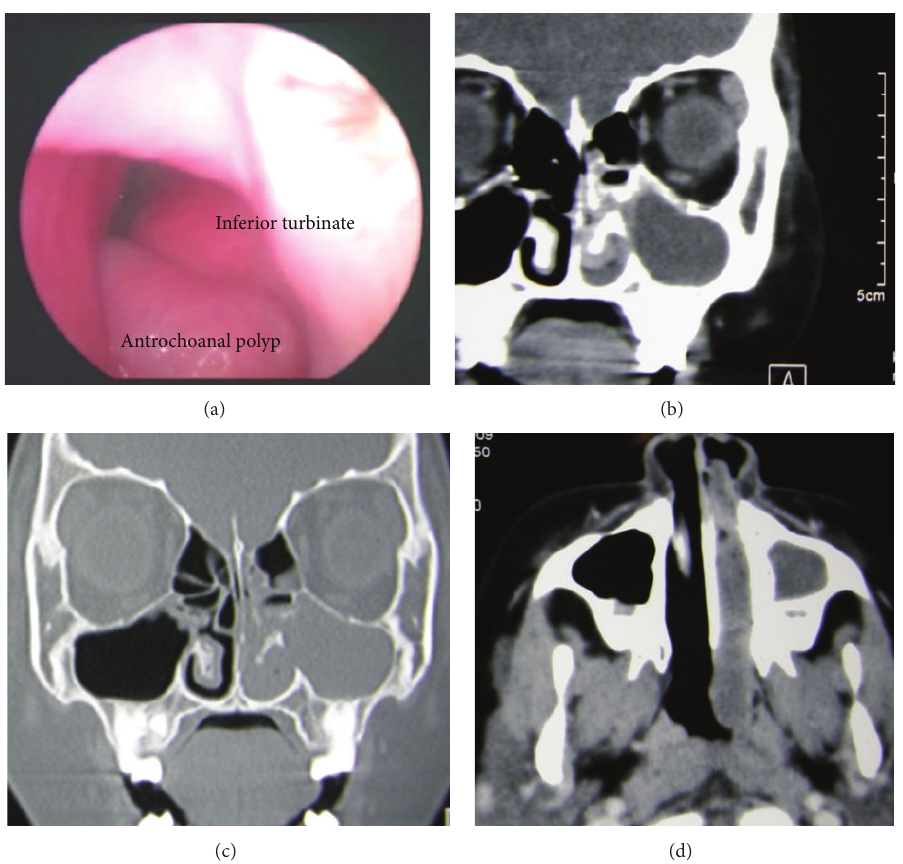
Figure 1: (a) Left nasal cavity endoscopic view showing antrochoanal polyp at inferior meatus CT scans. (b) Coronal view, soft tissue window showingcysticcomponentinthemaxillaryantrum.(c)Coronalview,bonewindowshowingdefectofmedialmaxillarywallbelowtheinferior turbinate. (d) Axial view, soft tissue window; polyp extending into the nasopharynx.